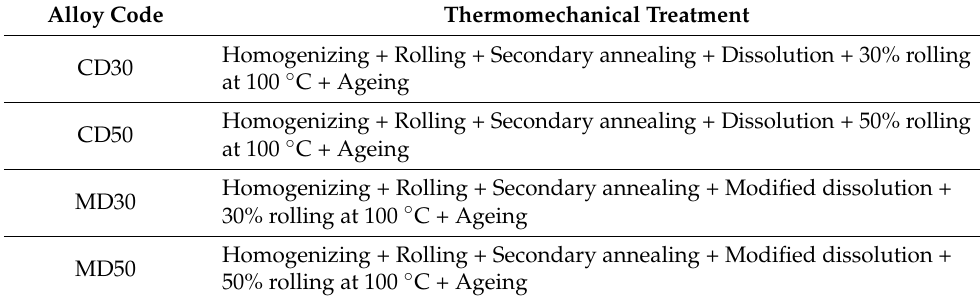
Figure 1. The schematic of thermomechanical treatments. Table 2. Specifications of Al-Zn-Mg-Cu-0.1%Zr-0.1%Sc alloys and the performed thermomechanical treatments.